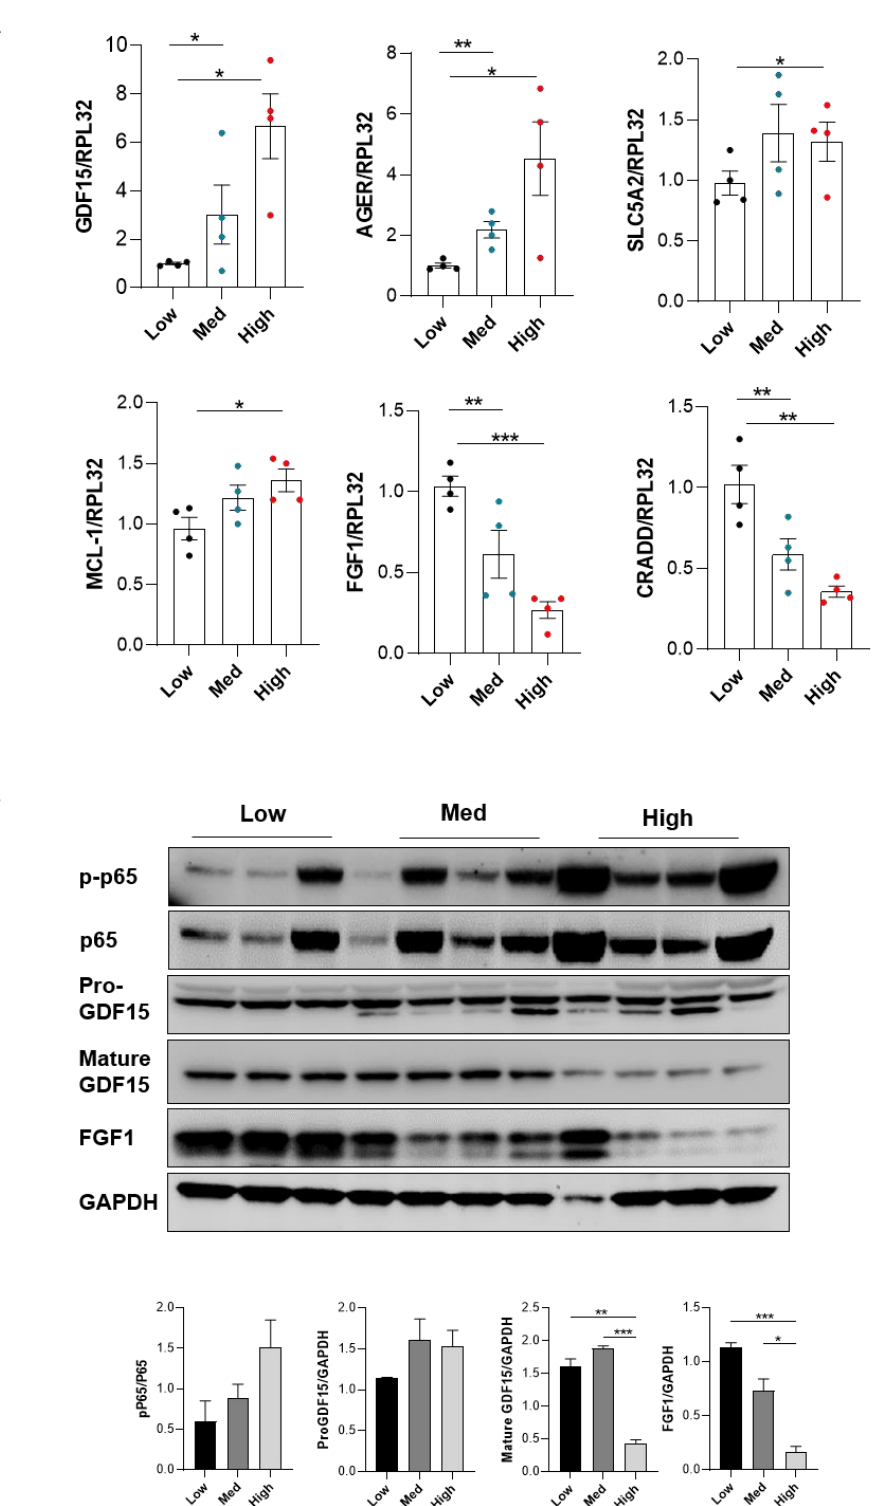
Figure 4. Periostin mediates renal inflammation and fibrosis through NF- κ B by repressing FGF1 and GDF15. Gene expression of GDF15, AGER, SCL5A2, MCL1, FGF1 and CRADD according to periostin level (genes expression was normalised by housekeeping genes (RPL32 and HPRT) ( A ). Immunoblotting showed protein expression of p-p65, p65, Pro-GDF15, mature GDF15 and FGF1 in kidney mice with low, medium and high periostin expression ( B ). * p < 0.05, ** p < 0,01, *** p < 0.001.